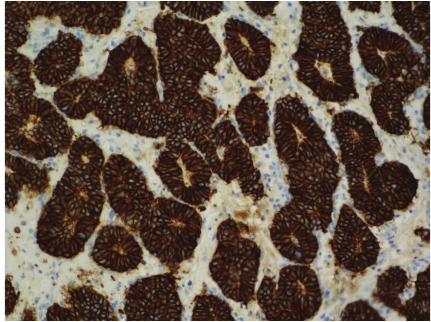
Figure 2: Further immunohistochemical analysis shows strong positive staining for CD56 (original magnification ×